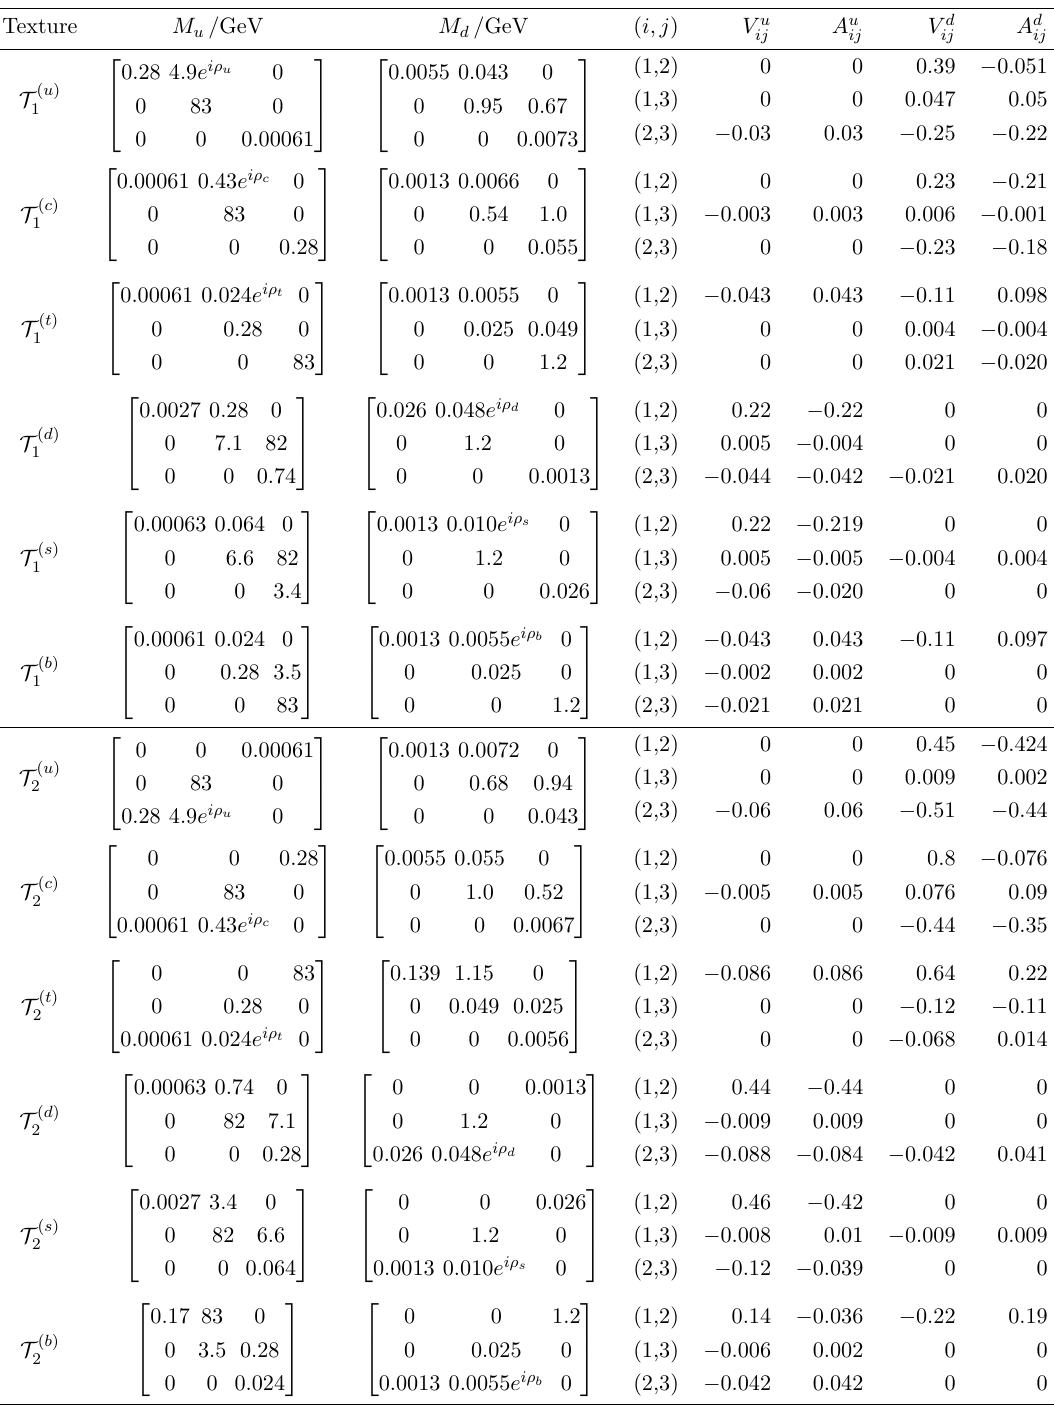
Table 2 . Input parameters m q (cid:12)tted to (cid:13)avour data at (cid:22) = 4 (cid:2) 10 12 GeV, and associated ij